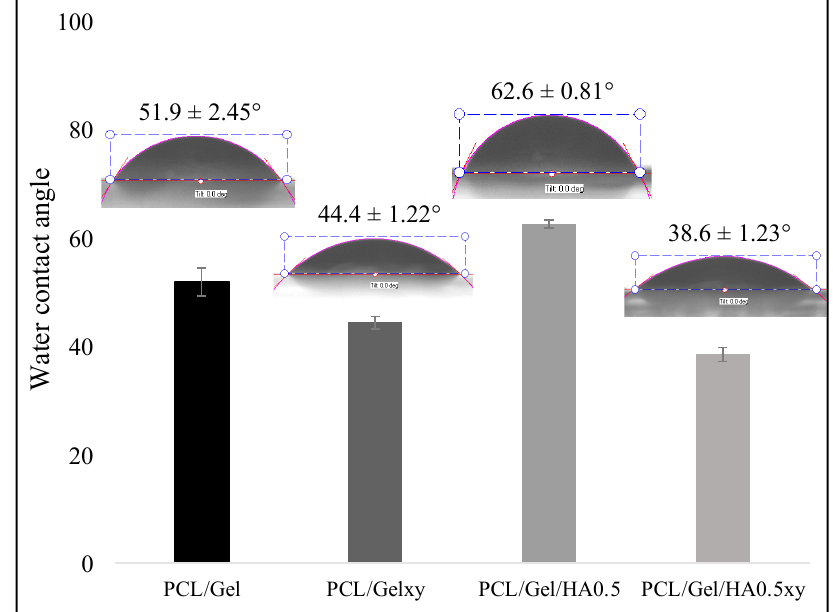
Figure 6. Water contact angle (WCA) of PCL/Gel, PCL/Gelxy, PCL/Gel/HA, and PCL/Gel/HAxy Figure6. Watercontactangle(WCA)ofPCL / Gel, PCL / Gelxy, PCL / Gel / HA,andPCL / Gel / HAxysca ff scaffolds.